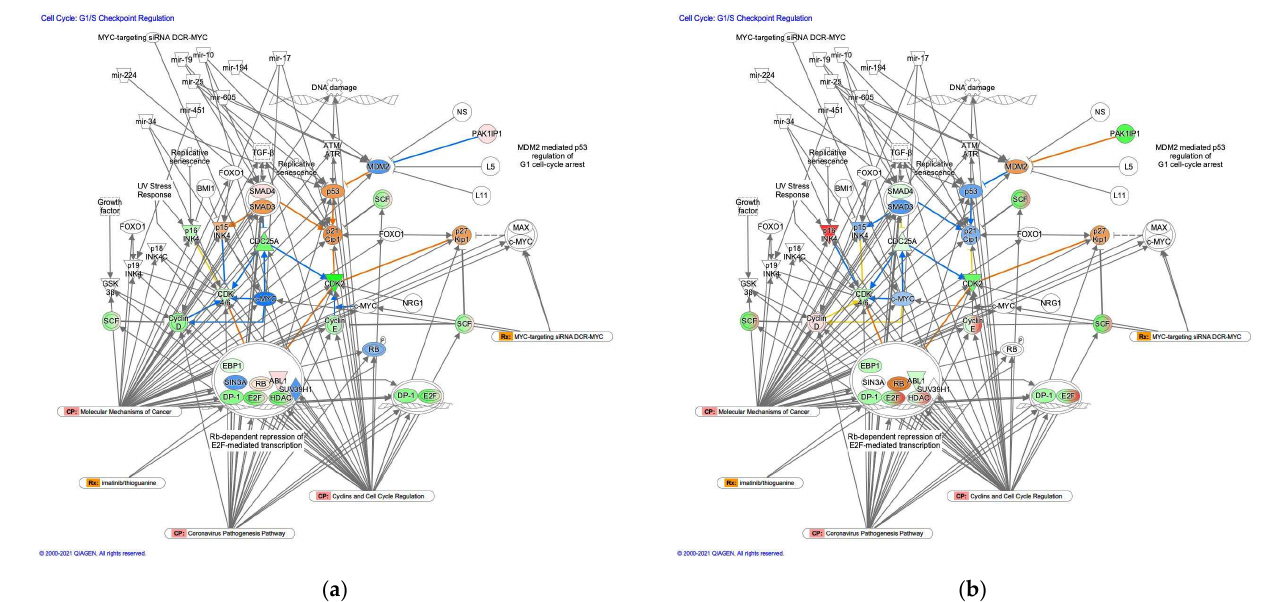
Figure 3. The G 1 /S cell cycle checkpoint regulation pathway was activated in diffuse-type GC. ( a ) Gene expression and pathway activity predictions in diffuse-type GC are shown. ( b ) Gene expression and pathway activity predictions in intestinal-type GC are shown. The genes whose expression was altered in diffuse- and intestinal-type GC are shown in pink (upregulated) or green (downregulated). Predicted activation and inhibition are shown in orange and blue, respectively. Table 3. Non-coding RNAs which have direct relationships in the G 1 /S cell cycle checkpoint regulation pathway. Symbol Entrez Gene Name